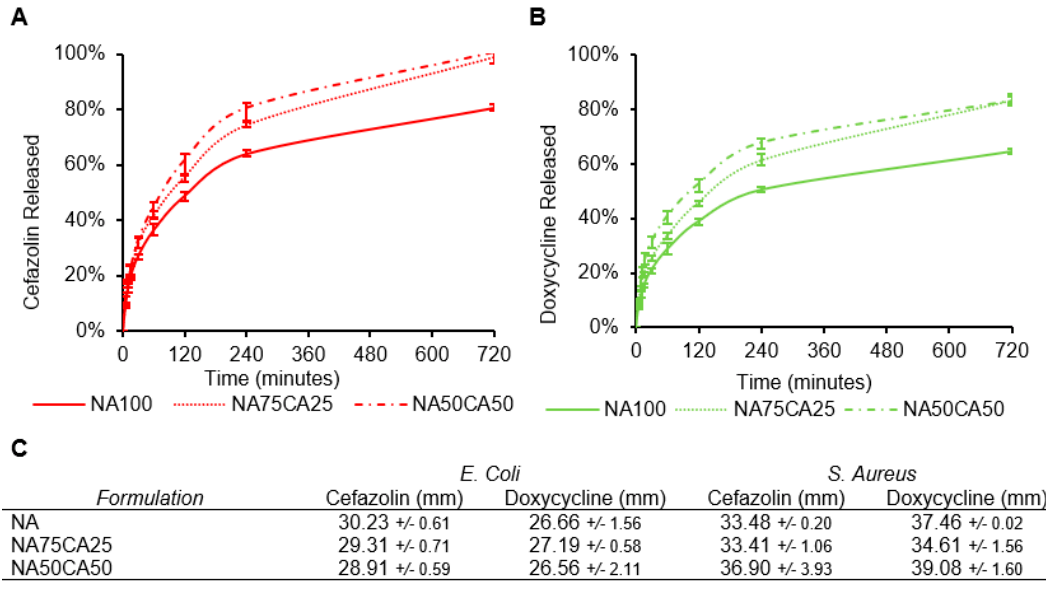
Figure 5. Release profiles of ( A ) cefazolin and ( B ) doxycycline in phosphate-buffed saline (PBS). The effect of CA on the acceleration of the release rate is apparent for the two types of antimicrobial agents tested. ( C ) Zone of inhibition of the three hydrogel formulations each loaded with 3 mg/mL of antimicrobial and tested on Escherichia coli and Staphylococcus aureus . (N = 3, standard